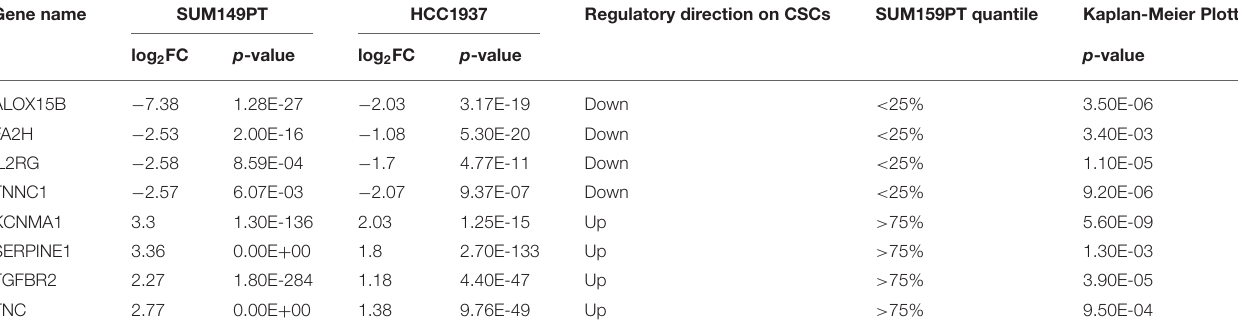
TABLE 2 | Candidate genes differentially expressed between stem and non-stem cell